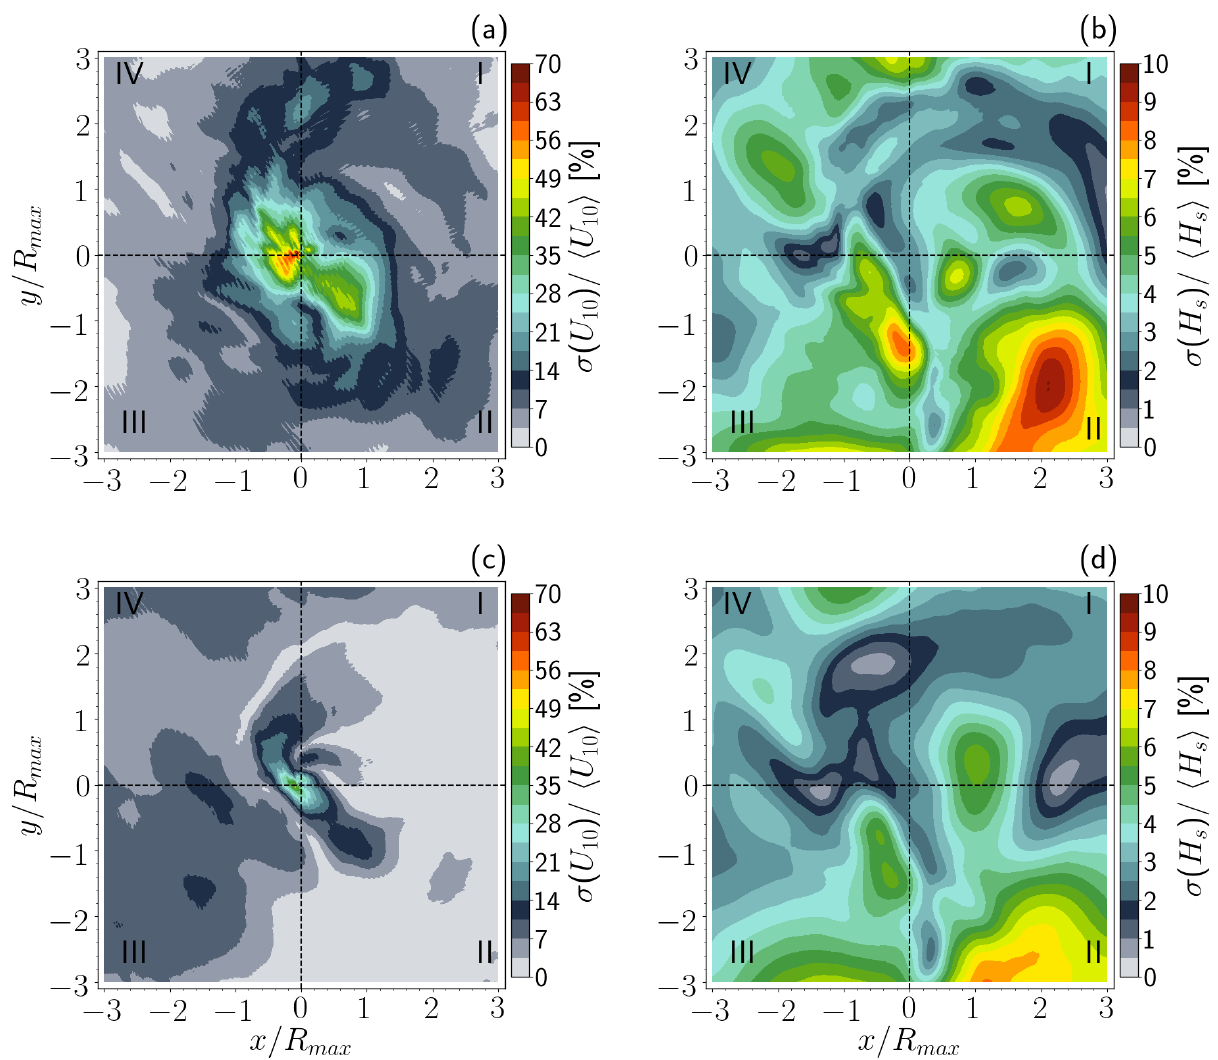
Figure 11. Average temporal variability fields of U 10 ( left ) and Hs ( right ) computed for the 3 h interval in which the storm becomes a category 1 hurricane. The top and bottom panels represent the results from the original ( a ) and ( b ) and filtered data ( c ) and ( d ),